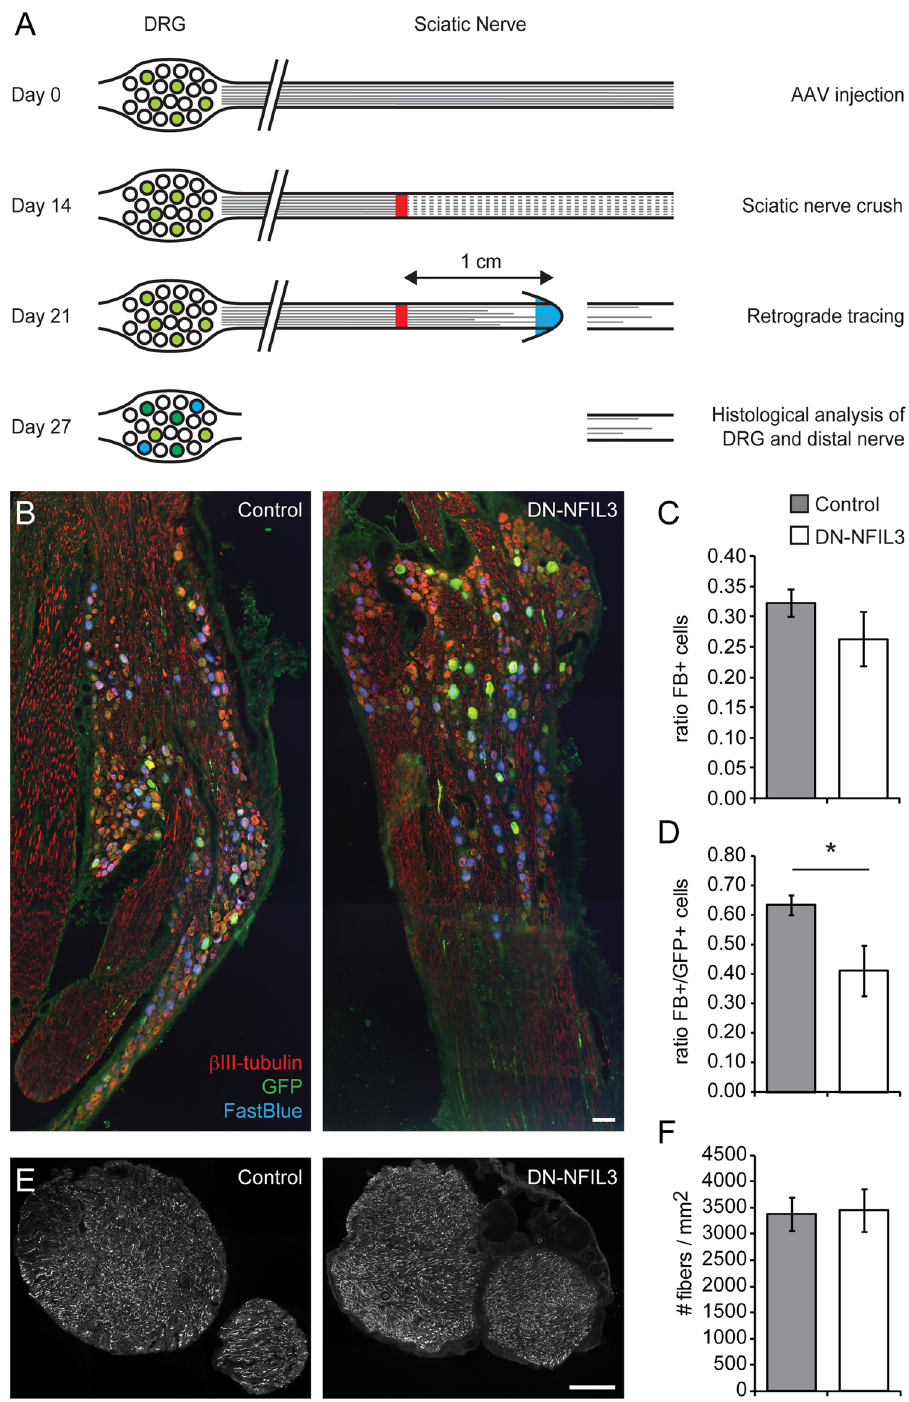
Fig 4. Dominant-negative inhibition of NFIL3 impairs regenerative axon growth in vivo . (a) Overview of the experimental design. At day 0 L4/L5 DRGs were injected with AAV5 virus expressing either DN-NFIL3 and GFP, or GFP only. At day 14 the animals received a unilateral crush of the sciatic nerve. At day 21 we transsected the sciatic nerve 1 cm distal from the crush and treated the proximal stump with the retrograde tracer FastBlue. The distal stump was removed for histological analysis. At day 27 animals were sacrificed, and the DRGs were removed for histological analysis. (b) Examples of control and DN-NFIL3 treated DRG sections stained with anti- β III-tubulin in red, anti-GFP in green, and showing FastBlue labeling in blue (scale